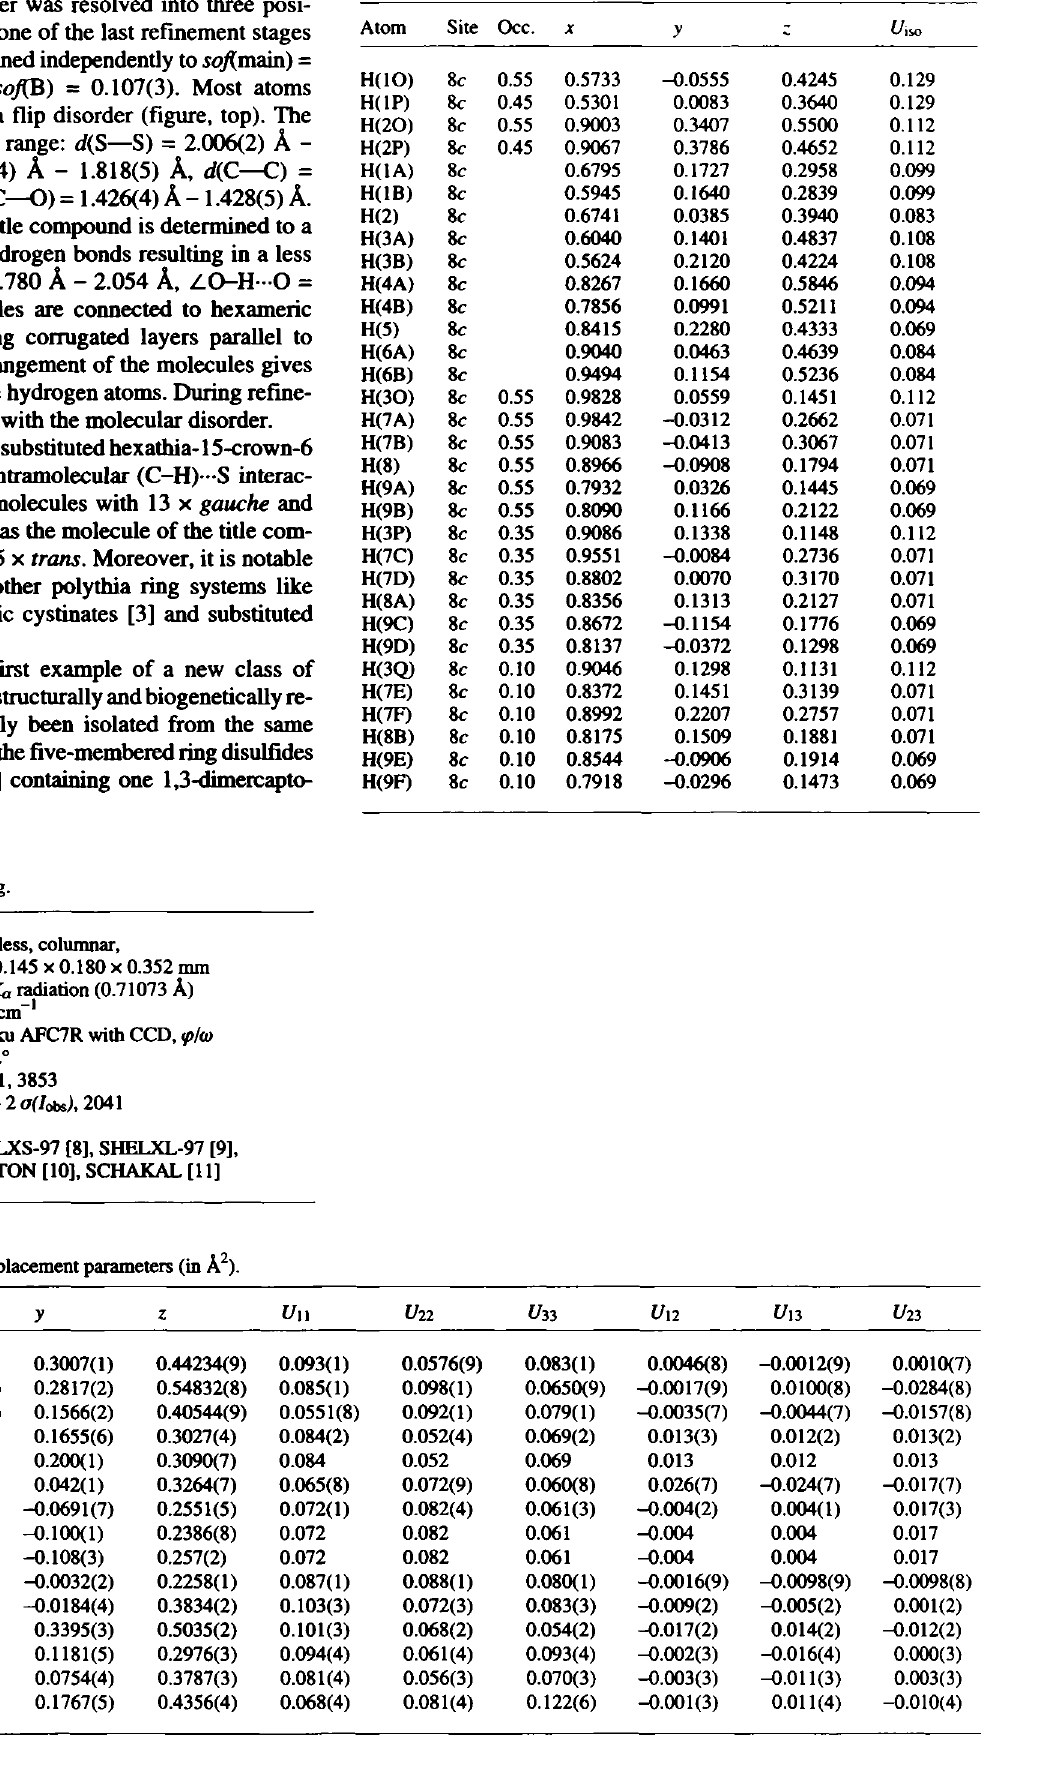
Table 1. Data collection and handling.